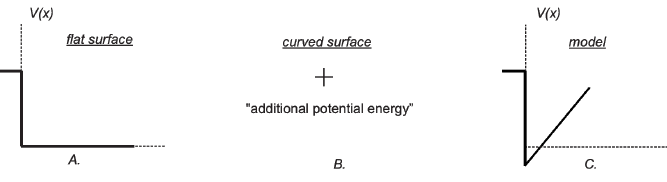
Figure 5. The profiles of the effective potentials at the reflection of X-rays by plane and curved surfaces (the scheme is reproduced from [41]). ( A ) The potential barrier for a plane surface; ( B ) Once the reflecting surface is curved, the reflection potential reveals an additional potential energy; ( C ) The potential barrier for a curved